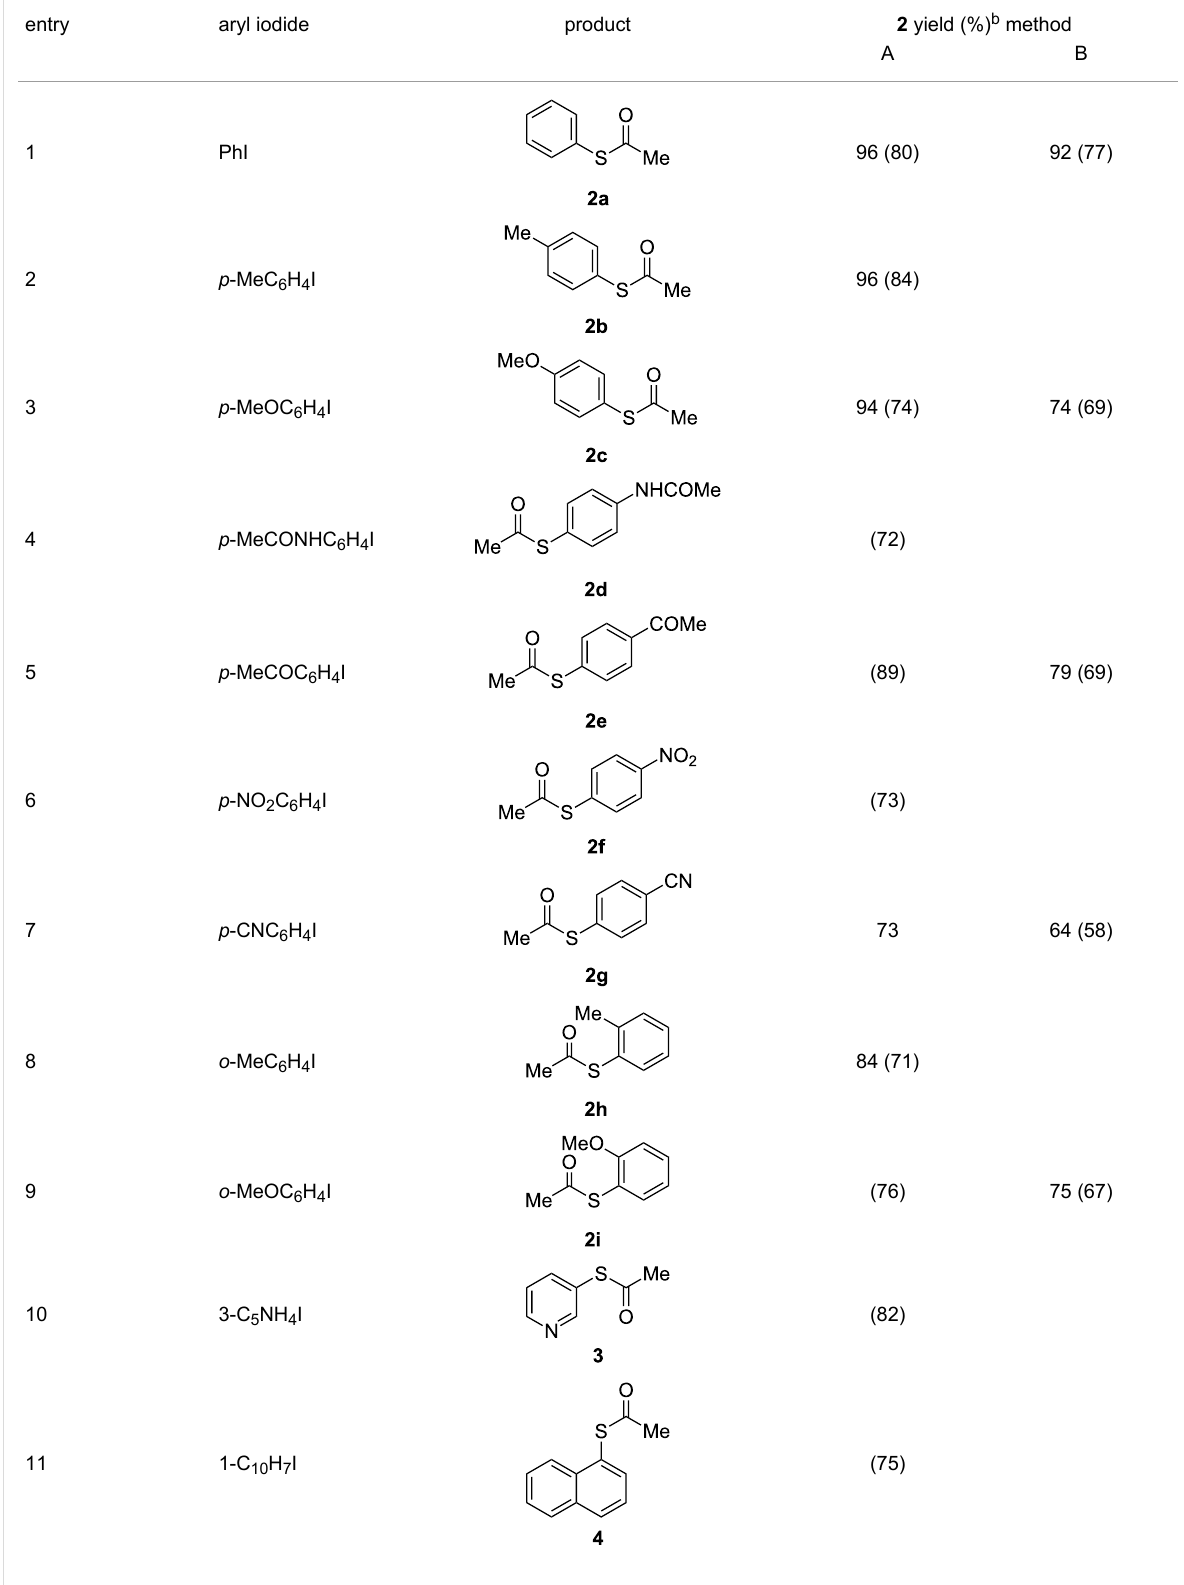
Table 3: Copper-catalyzed reaction of aryl iodides with potassium thioacetate ( 1 ).